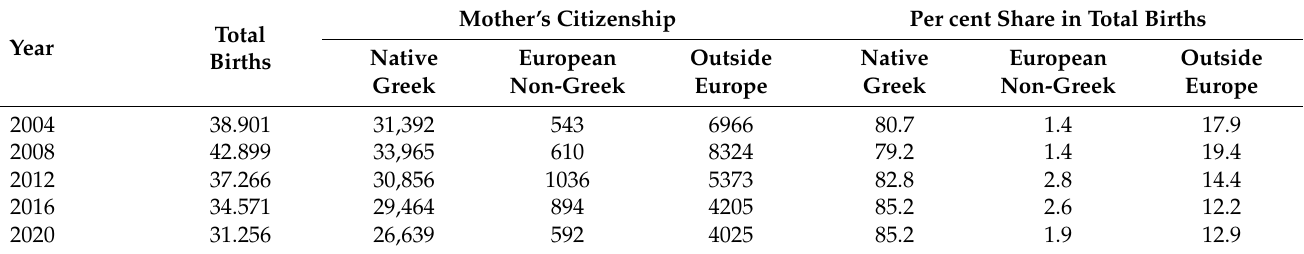
Table 3. Live births in Attica by mother’s citizenship, 2004–2020.